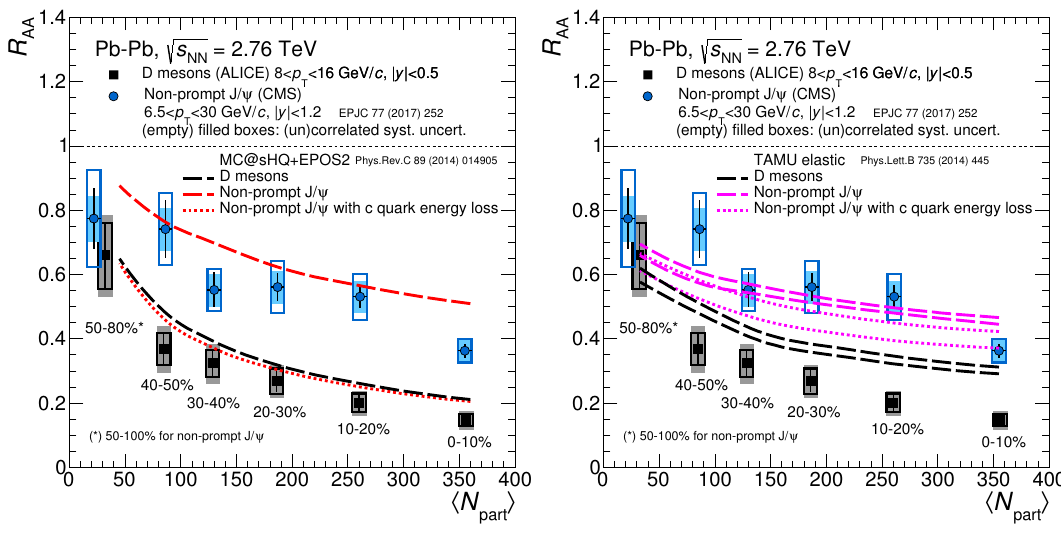
Figure 3 . Comparison of the R AA measurements with the MC@sHQ + EPOS2 model [5] including radiative and collisional interactions (left) and with the TAMU elastic model [6] including collisional interactions via in-medium resonance formation. For both models, results for the case in which the b quark interactions are calculated using the c quark mass are shown as well [7]. In the right-hand panel, the band between lines with the same style represents the theoretical uncertainty. This (cid:12)gure updates (cid:12)gure 5 of